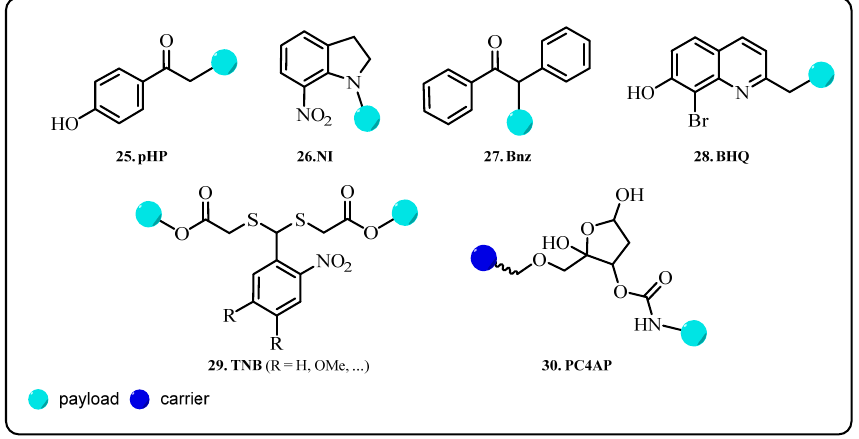
Figure 4. Representative photoprotecting groups used in drug conjugates.